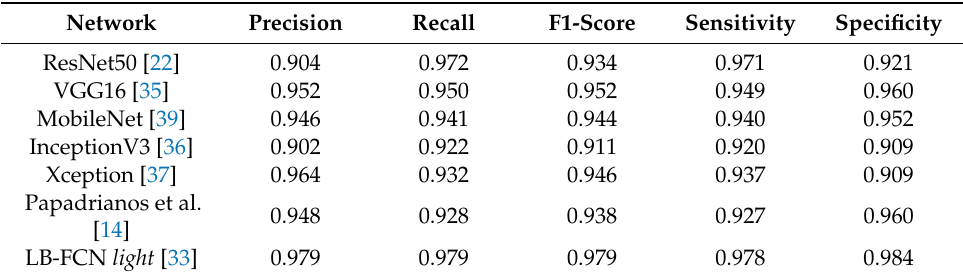
Table 3. Comparative classification performance for the malignant disease